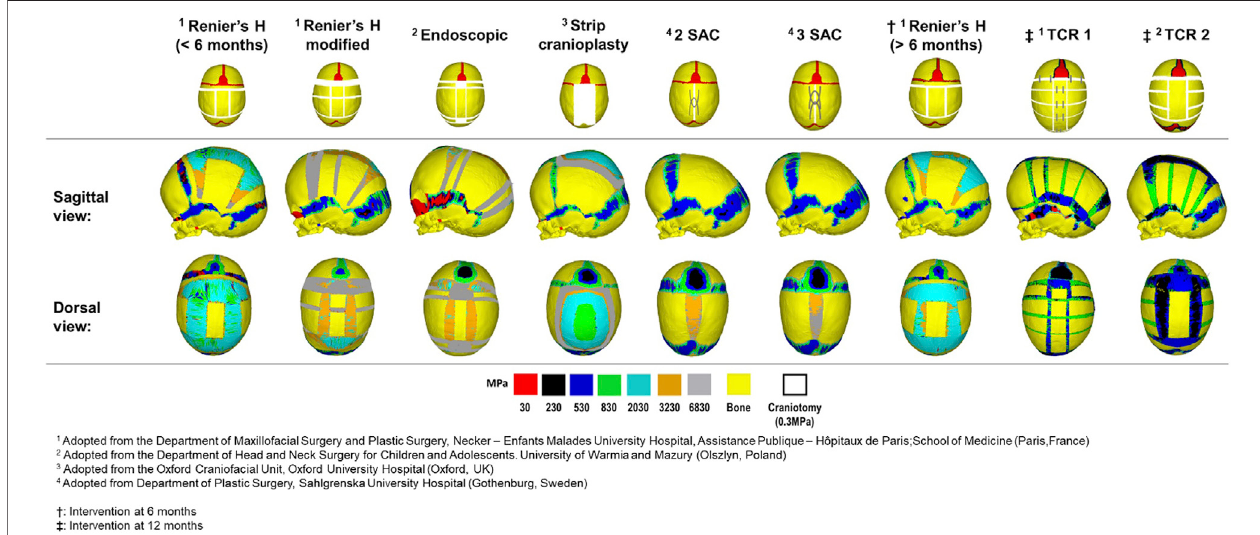
FIGURE 2 | Predicted bone formation across all replicated techniques at the postoperative age of 76 months. The material properties across the newly and previously selected elements were updated at each load step.